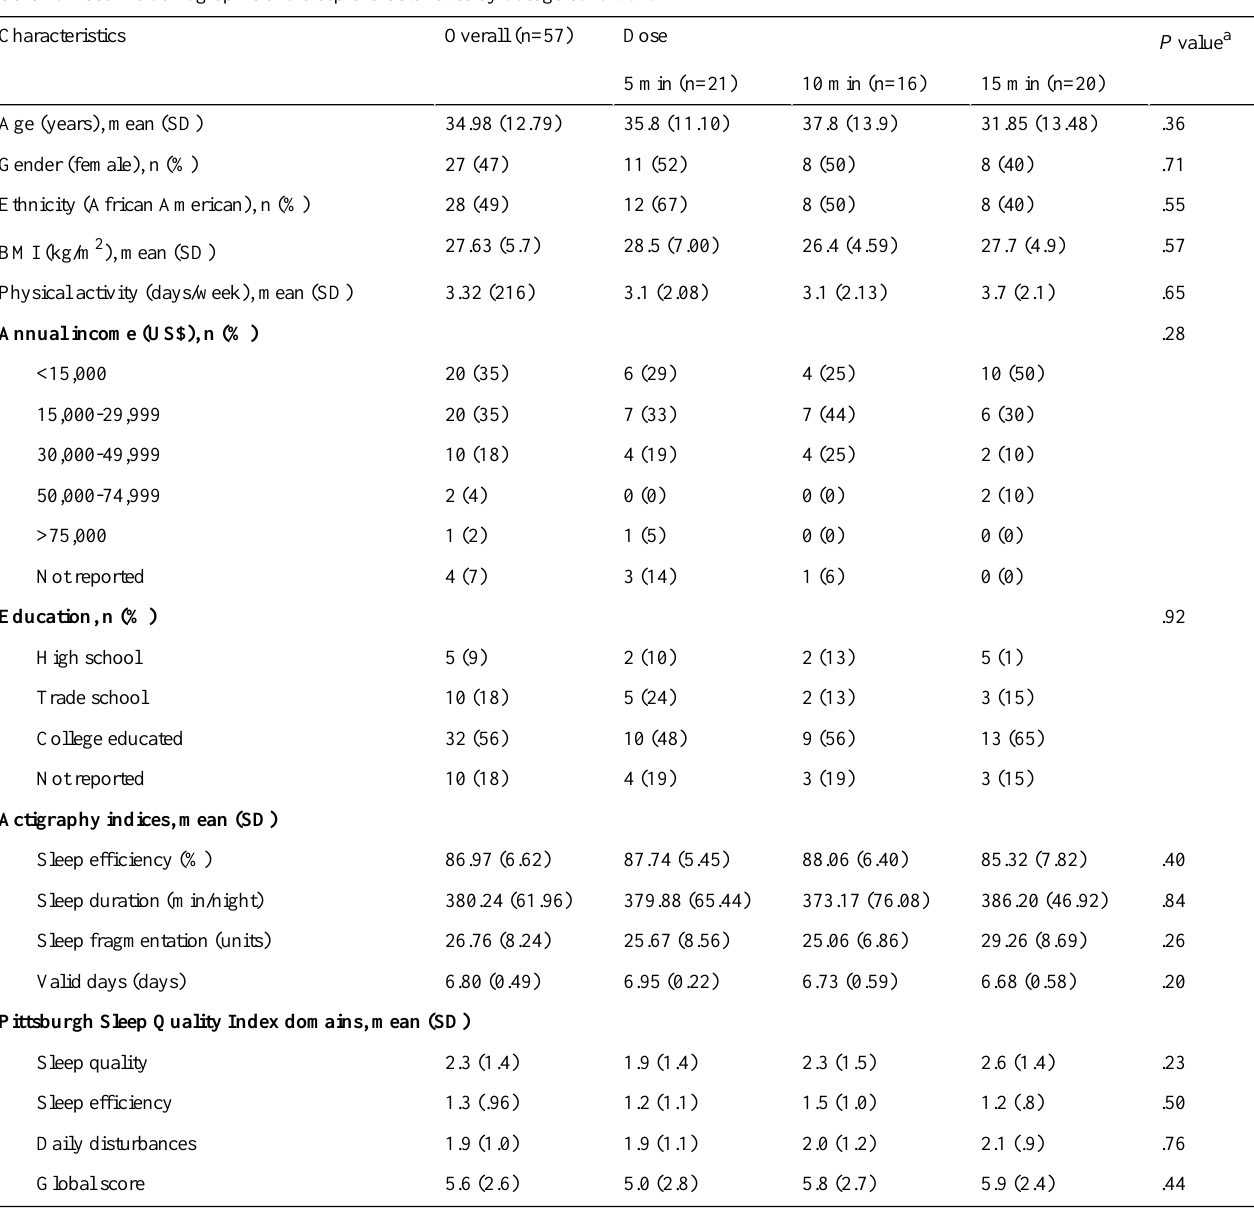
Table 1. Baseline demographic and sleep characteristics by dosage